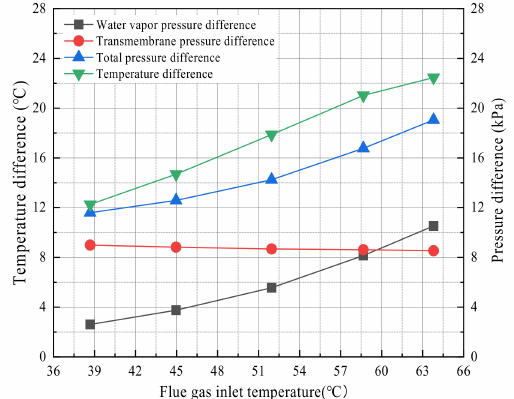
Figure 19. The driving force for moisture and waste heat recovery. Experiment conditions: flue gas flow 9.85 L/min, negative pressure airflow 15 L/min, negative pressure air inlet temperature 12.95 ◦ C, membrane pore size 10